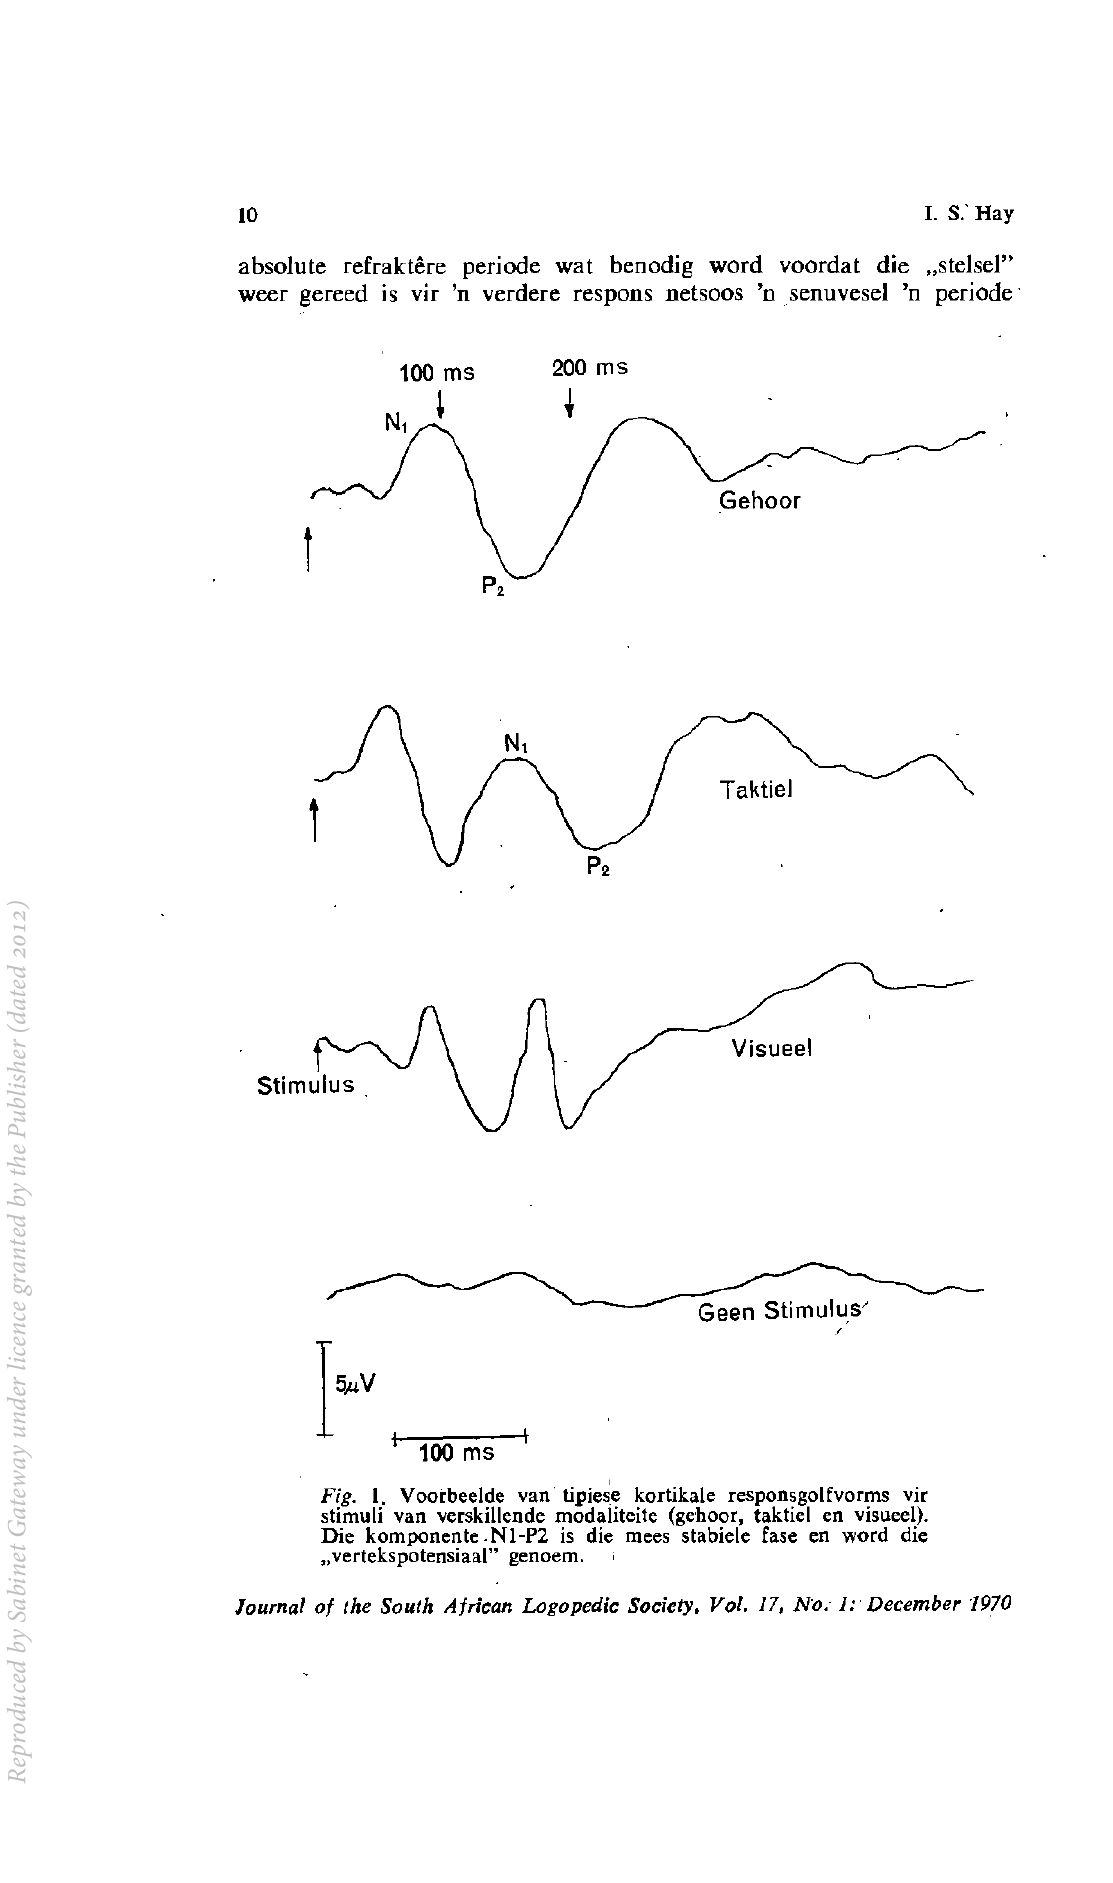
Fig. 1. Voorbeelde van tipiese kortikale responsgolfvorms vir stimuli van verskillende modaiiteite (gehoor, taktiel en visueel). Die komponente N1-P2 is die mees stabiele fase en word die „vertekspotensiaal" genoem.